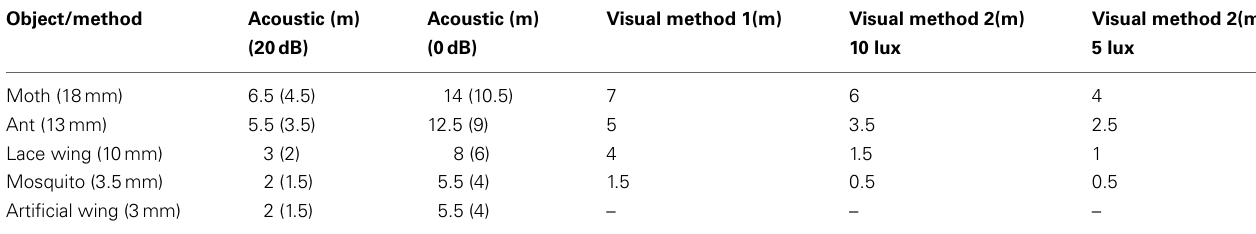
Table 2 | Echolocation and visual detection ranges for R. microphyllum